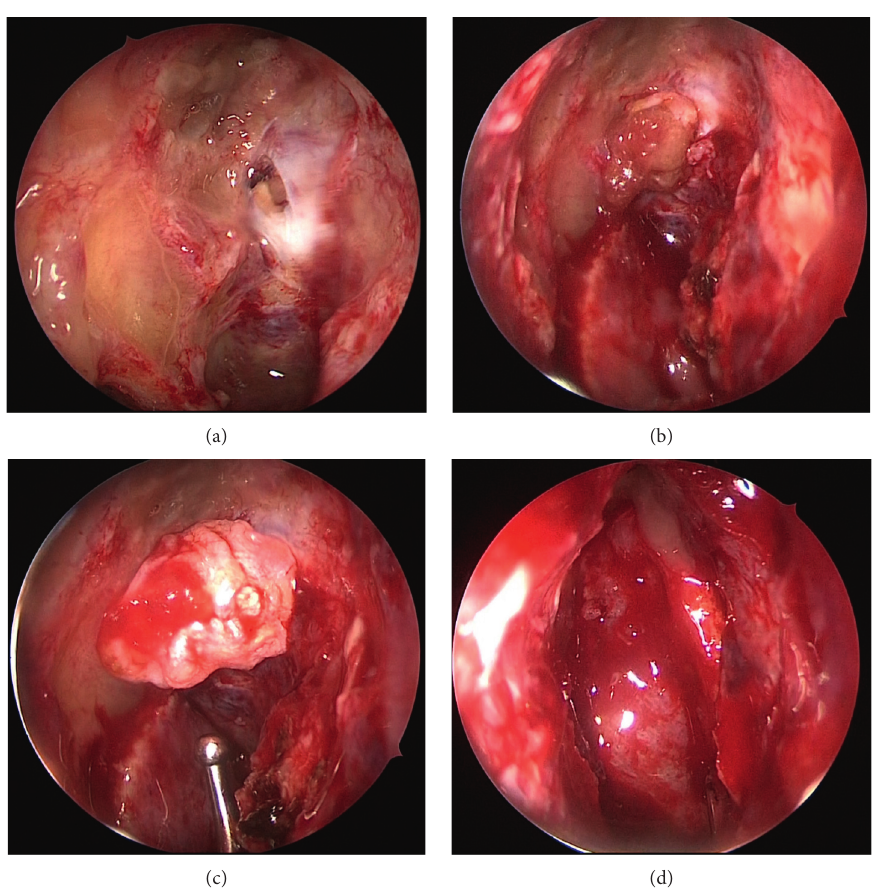
Figure 3: Intraoperative findings. (a) The bone defect and cerebrospinal fluid leaks were found in the right frontal ethmoidal skull base. (b) A piece of fascia was introduced through the dural defect into the intracranial cavity. The graft was gently pulled with forceps to plug the fistulae. (c) Another piece of fascia was placed as an overlay graft as the second layer. (d) A septal mucosal flap was placed as the third layer.